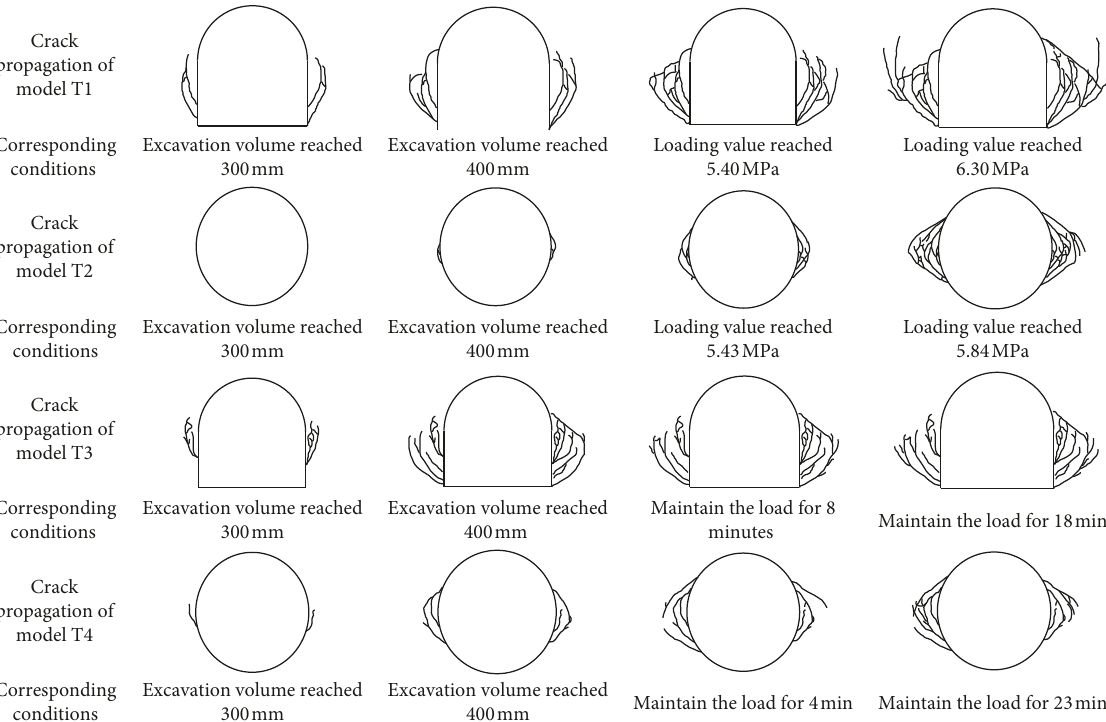
Figure 10: The process of macrocrack propagation around a tunnel during excavation, loading, and